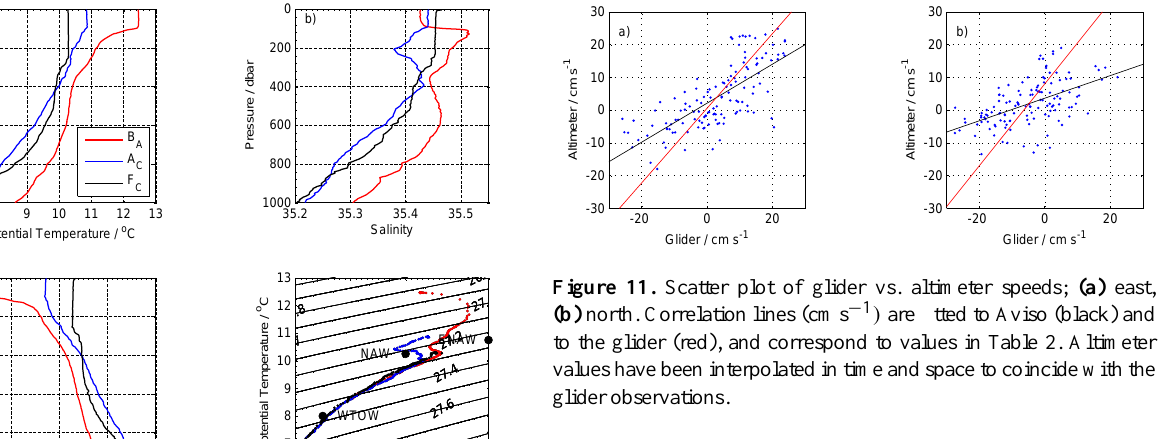
were always 2 times greater than the surface altimeter speeds (Table